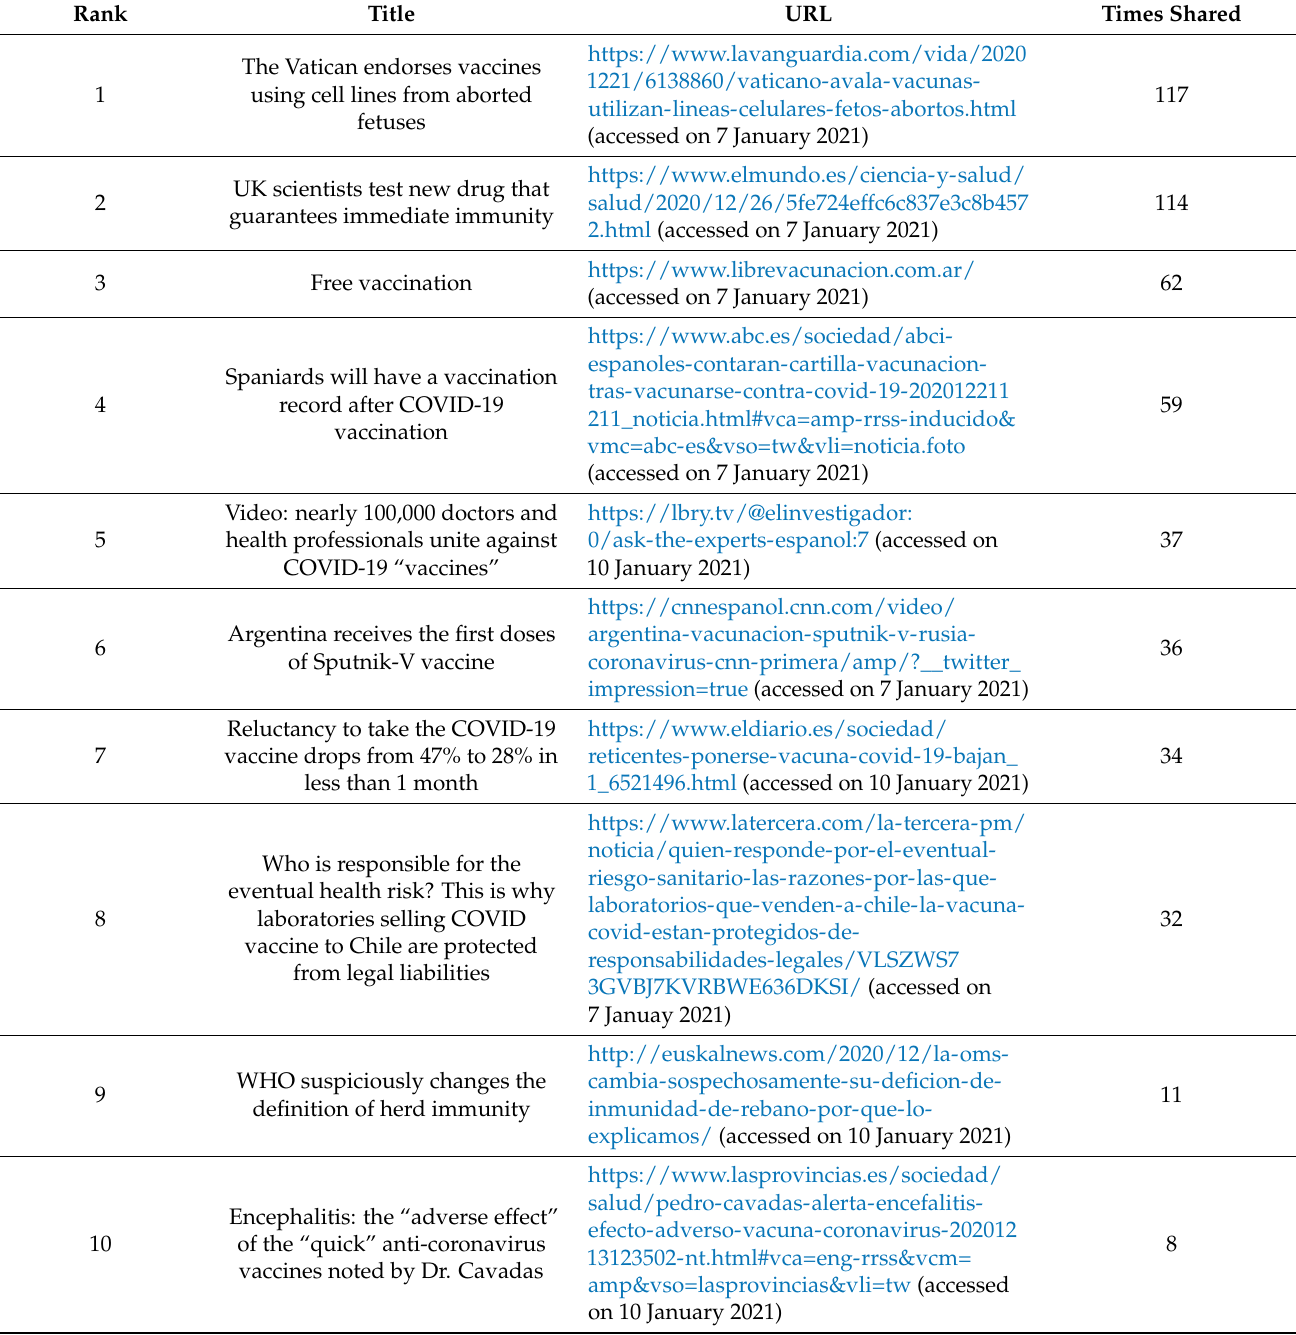
Table 5. Most shared URLs within antivaccine